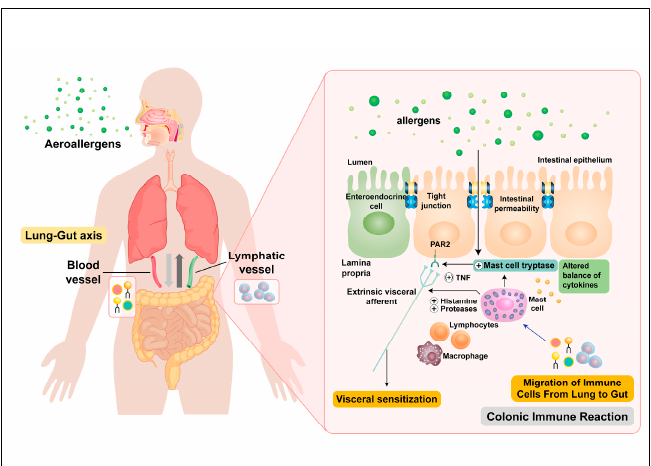
Figure 6. Overview of the pathophysiology of intestinal inflammation induced by aeroallergen. Proposed regulation of disease exacerbation by the lung-gut axis. When the lung immune system is disturbed, for example, during infection or allergen exposure, the intestinal immune system is altered as well by migration of immune mediators from lung to gut. Direct inflammatory reactions can also be induced in the intestine by the ingestion of aeroallergens.